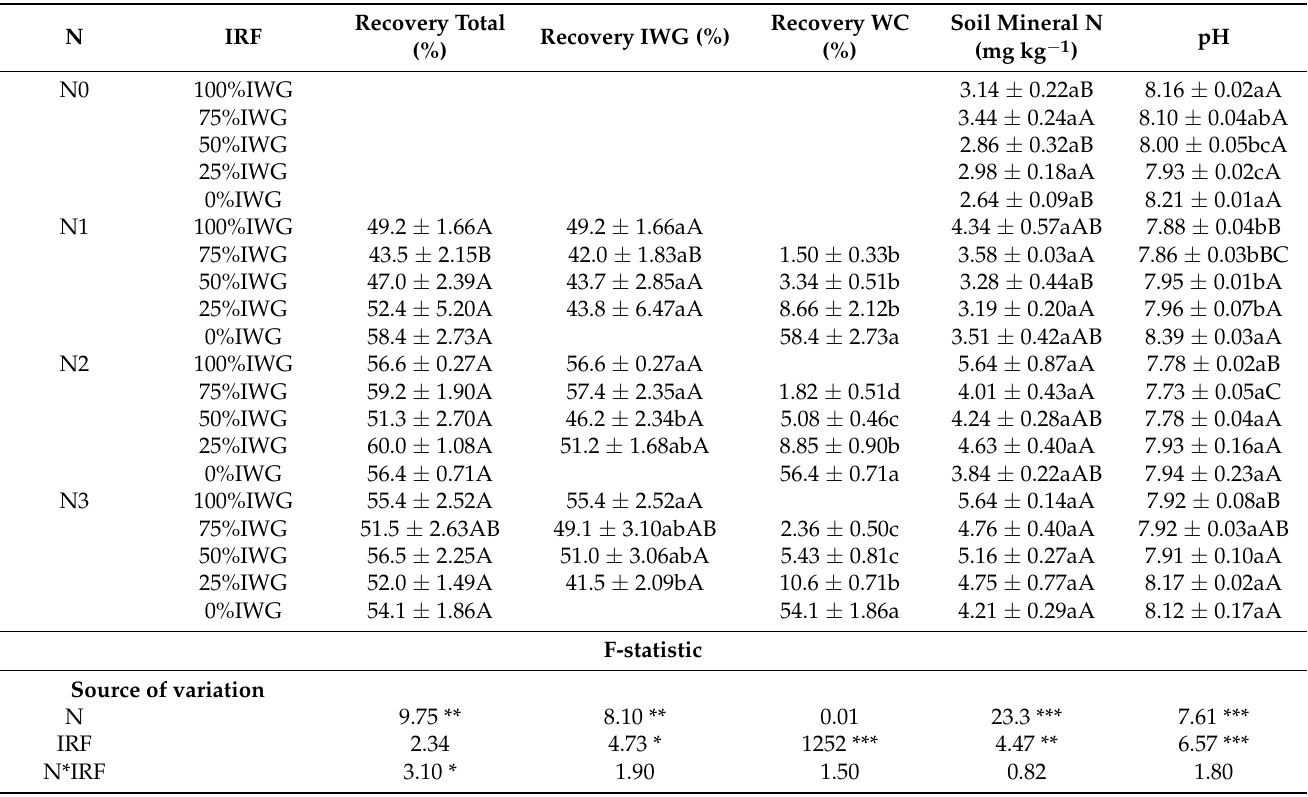
Table 4. The total fertilizer N recovery (Recovery total), N recovery of intermediate wheatgrass (Recovery IWG) and white clover (Recovery WC), the concentration of soil mineral N, and pH value under five relative frequencies of IWG (IRF) and four N fertilizer levels (N). Data are presented as mean ± standard error. F-statistics and significance from ANOVA are reported below the treatment